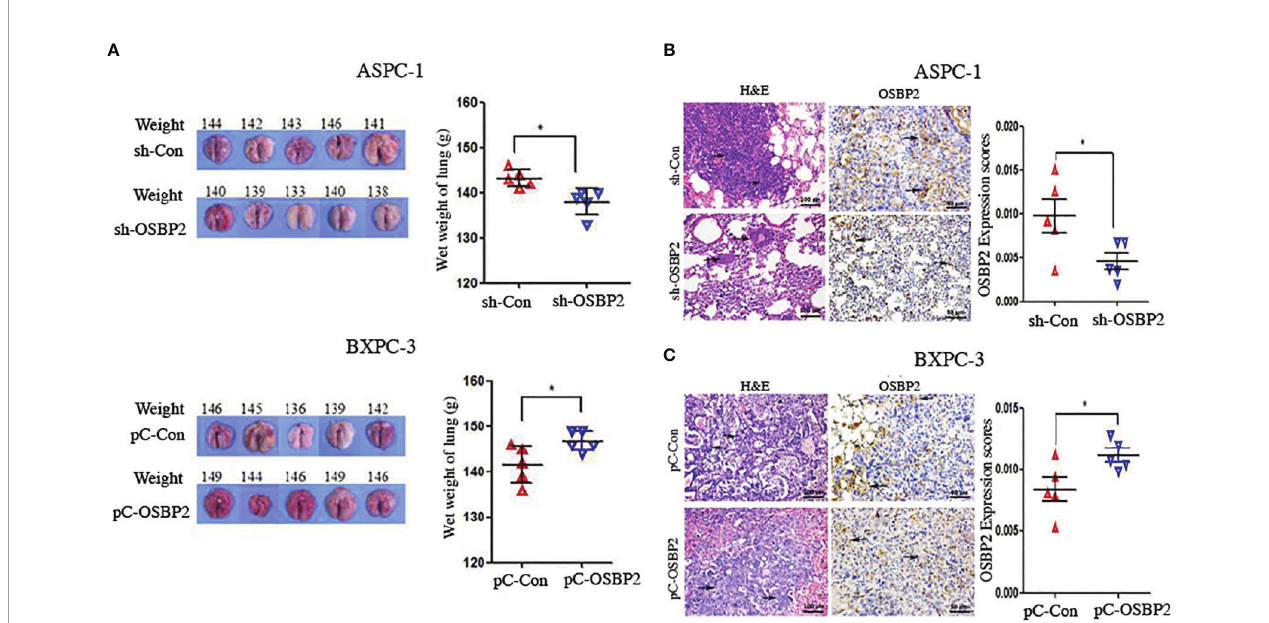
FIGURE 7 | OSBP2 promotes PDAC cell invasion in vivo . (A) Photographs of excised tumors from SCID mice and the lung weights calculated at the end of the experiment. (B, C) Pathologic analysis of tissue sections from recipient mice at 8 weeks post-injection. H&E (magni fi cation, 200×) and OSBP2 staining (magni fi cation, 200×) were performed. Normalization of OSBP2 expression is shown on the right. OSBP2, oxysterol-binding protein 2; PDAC, pancreatic ductal adenocarcinoma; sh, shRNA; pC, pcDNA3.1 plasmid. *P <